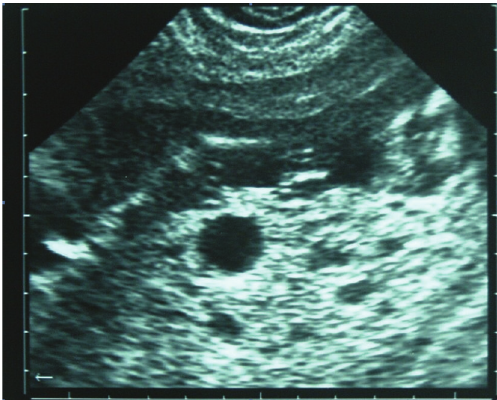
Figure 2: Ultrasound: Placentomegaly with multiple large anechoic areas. Is the entity partial